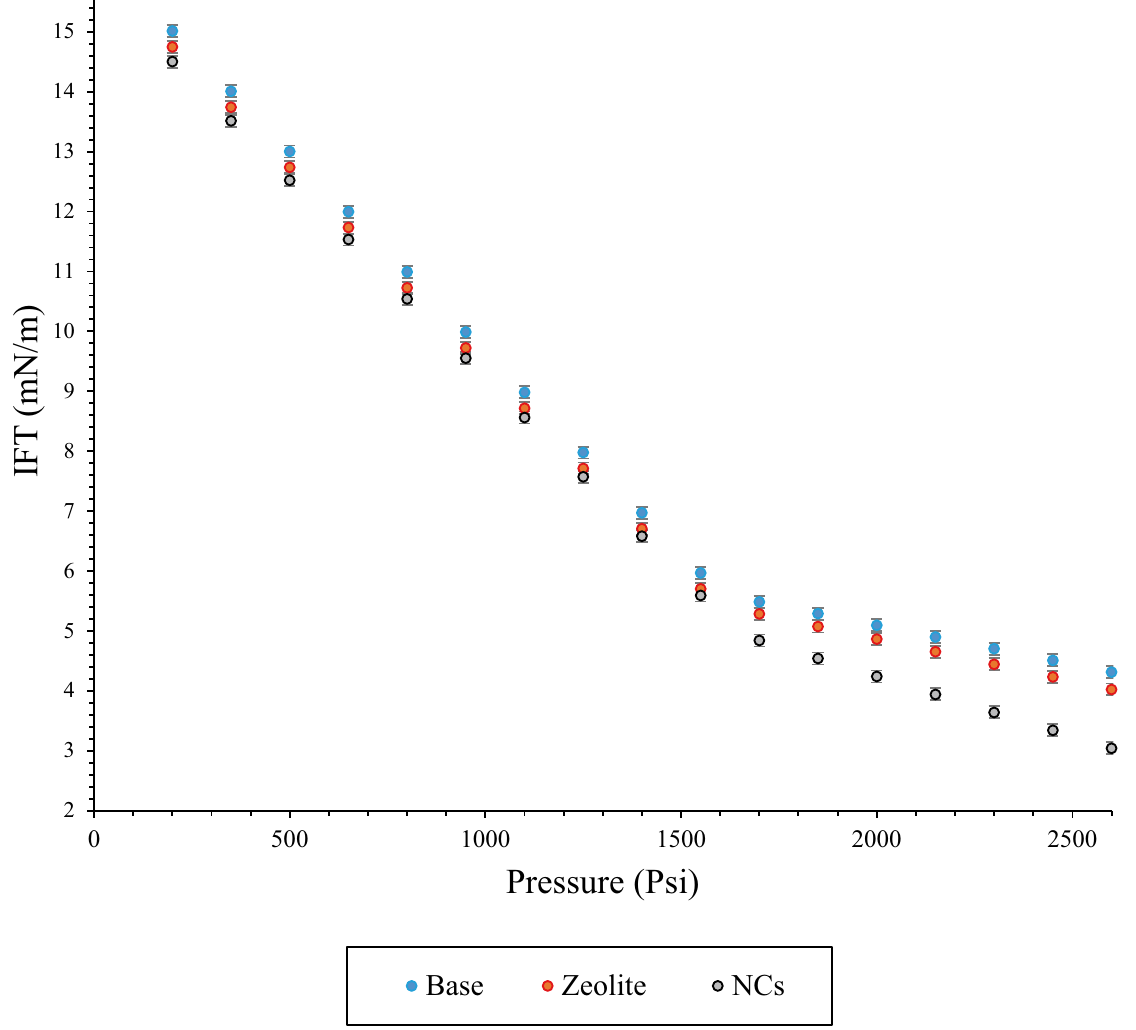
Figure 9. Effects of pressure and nanoparticles (NCs and zeolite) on CO 2 -oil IFT.